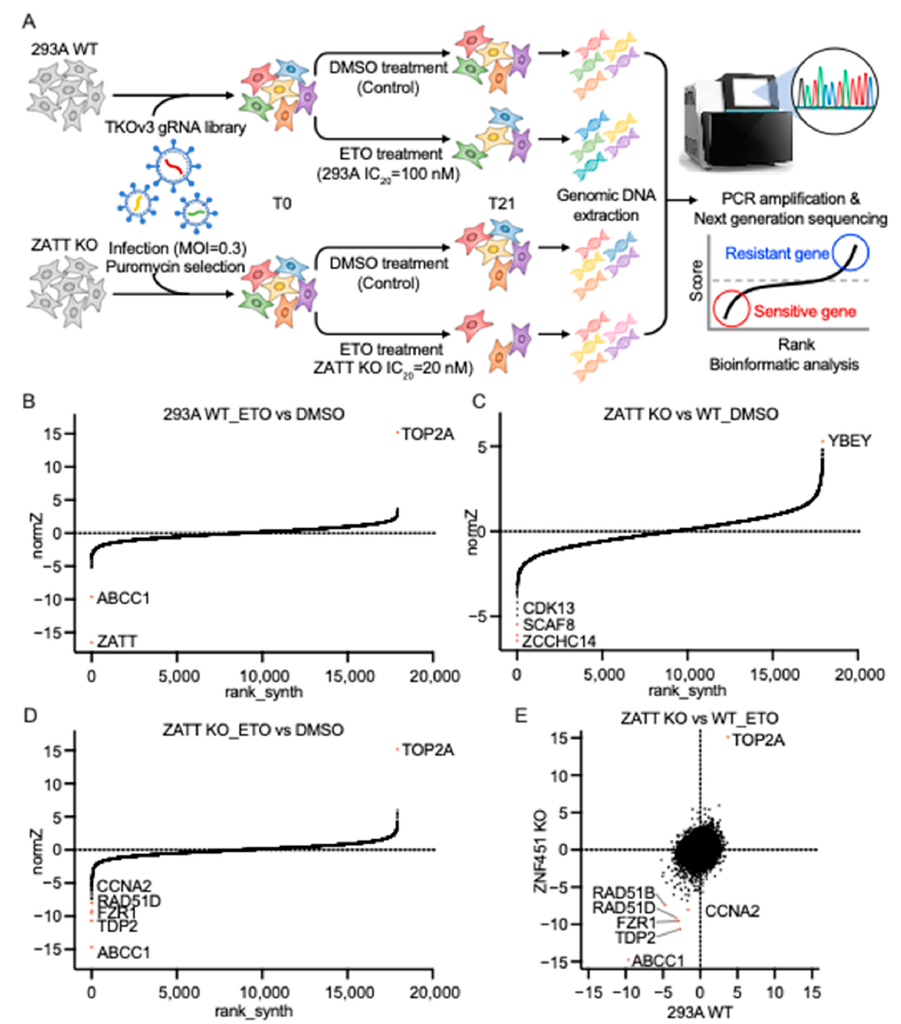
Figure 5. Genome-wide CRISPR screens identified ZATT as a critical gene important for ETO sensitivity. ( A ) Schematic diagram of the workflow for the CRISPR screens performed in parental 293A and ZATT KO cells with or without ETO treatment. TKOv3, Toronto Knock Out Library v3; MOI, the multiplicity of infection; DMSO, dimethyl sulfoxide; NGS, next-generation sequencing. ( B ) Ranking of ETO coessential genes based on a drug Z analysis of the results of CRISPR/Cas9 screening in 293A-WT cells. The z-score was used to define a possible synthetic lethal interaction with ETO. The ETO-treated group and DMSO treatment group in WT cells were compared. Genes whose loss of function led to ETO sensitivity appear on the left side, with a minus Z score, and genes whose loss of function led to ETO resistance appear on the right side, with a positive Z score. Top-ranked genes on either side are marked. ( C ) Ranking of ETO coessential genes based on a drug Z analysis of the results of CRISPR/Cas9 screening in ZATT KO cells. The ETO-treated group and DMSO group in ZATT KO cells were compared. ( D ) Ranking of ZATT coessential genes based on a drug Z analysis of the results of CRISPR/Cas9 screening. The z score was used to define a possible synthetic lethal interaction with ZATT. The DMSO ZATT KO cell group and DMSO 293A-WT cell group were compared. ( E ) Combinational comparison of ETO coessential genes between 293A-WT and ZATT KO cells. The z-scores from C and D were